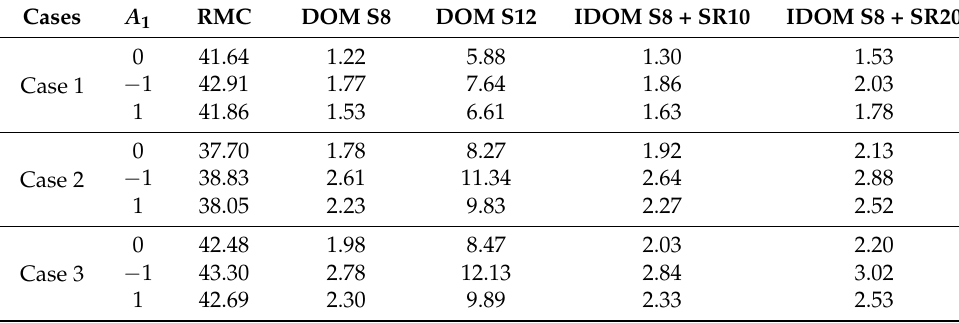
Table 2. Calculation times consumed by different methods,